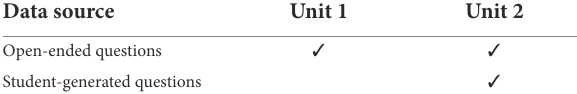
TABLE 1 Data sources for units 1 and 2.